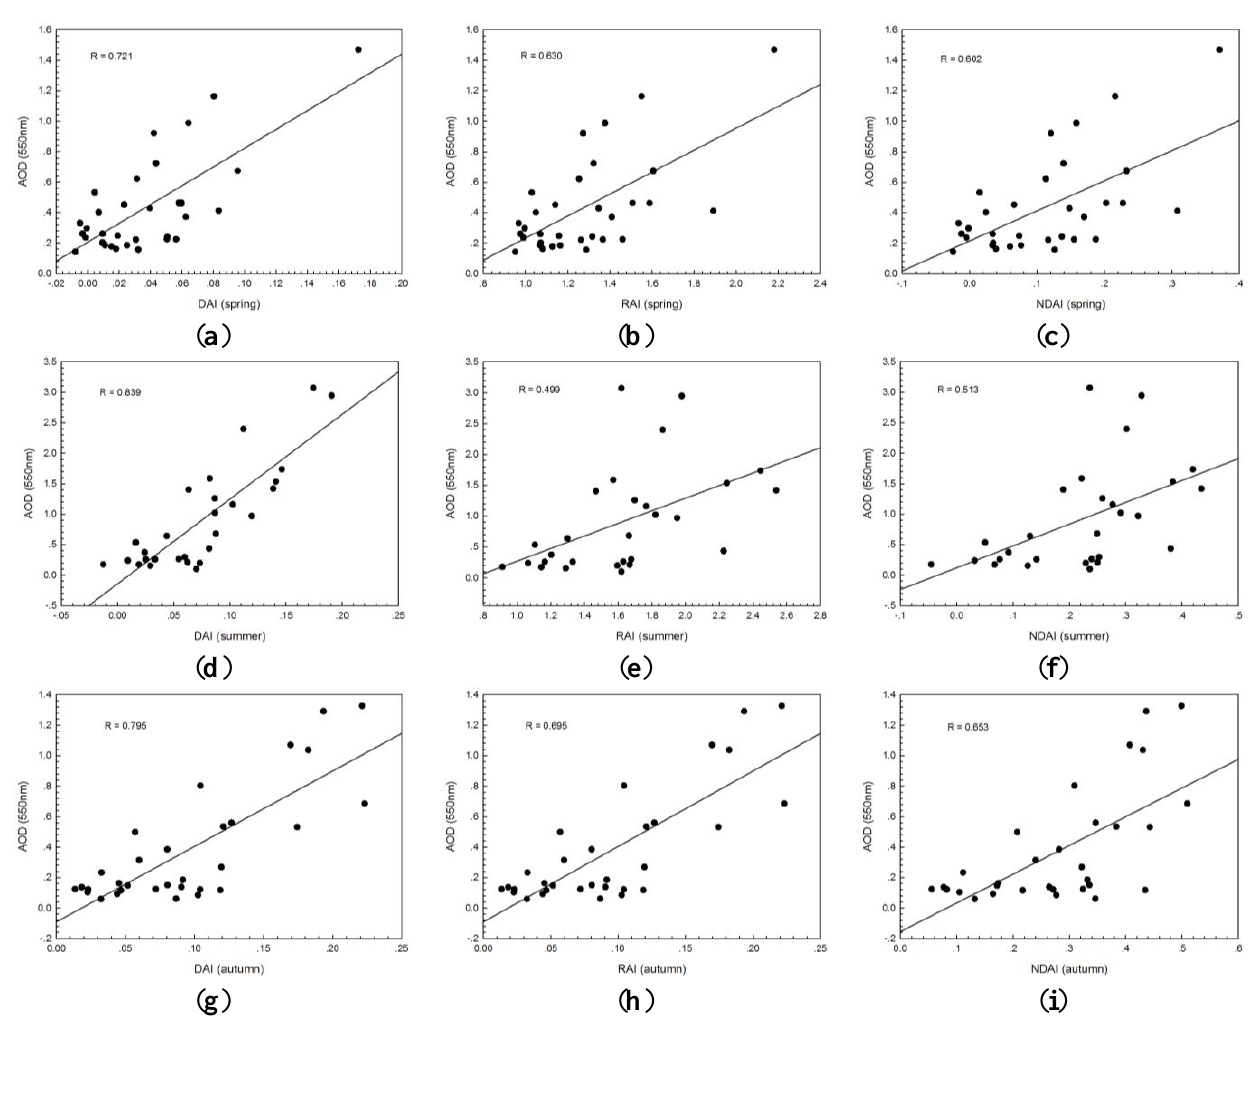
Figure A2. Regression results of the three proposed aerosol indices (DAI, RAI, NDAI) against AOD (550 nm) as observed at the Beijing station. ( a – c ) spring; ( d – f ) summer; ( g – i ) autumn; ( j – l )